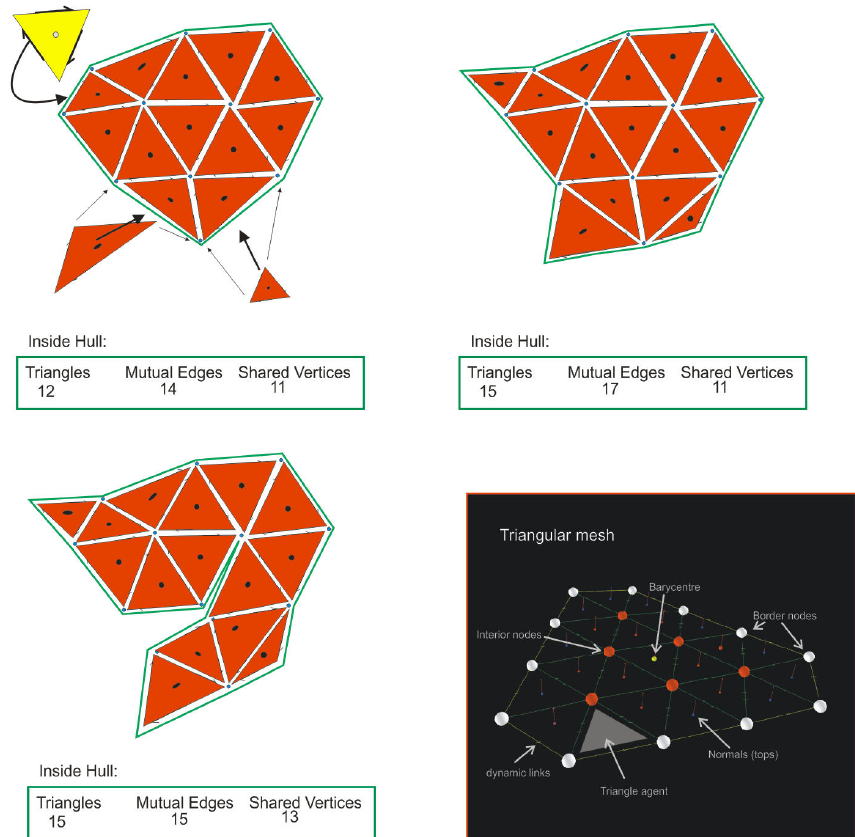
Figure 4. Spatial agent-based triangular meshing created from the Mesh program. See Appendix B for details.